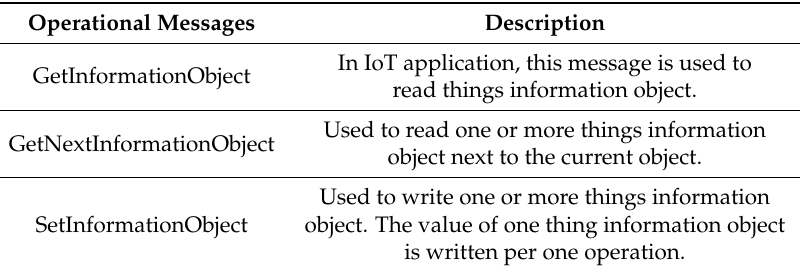
Table 4. TMP Operational Requests/Response